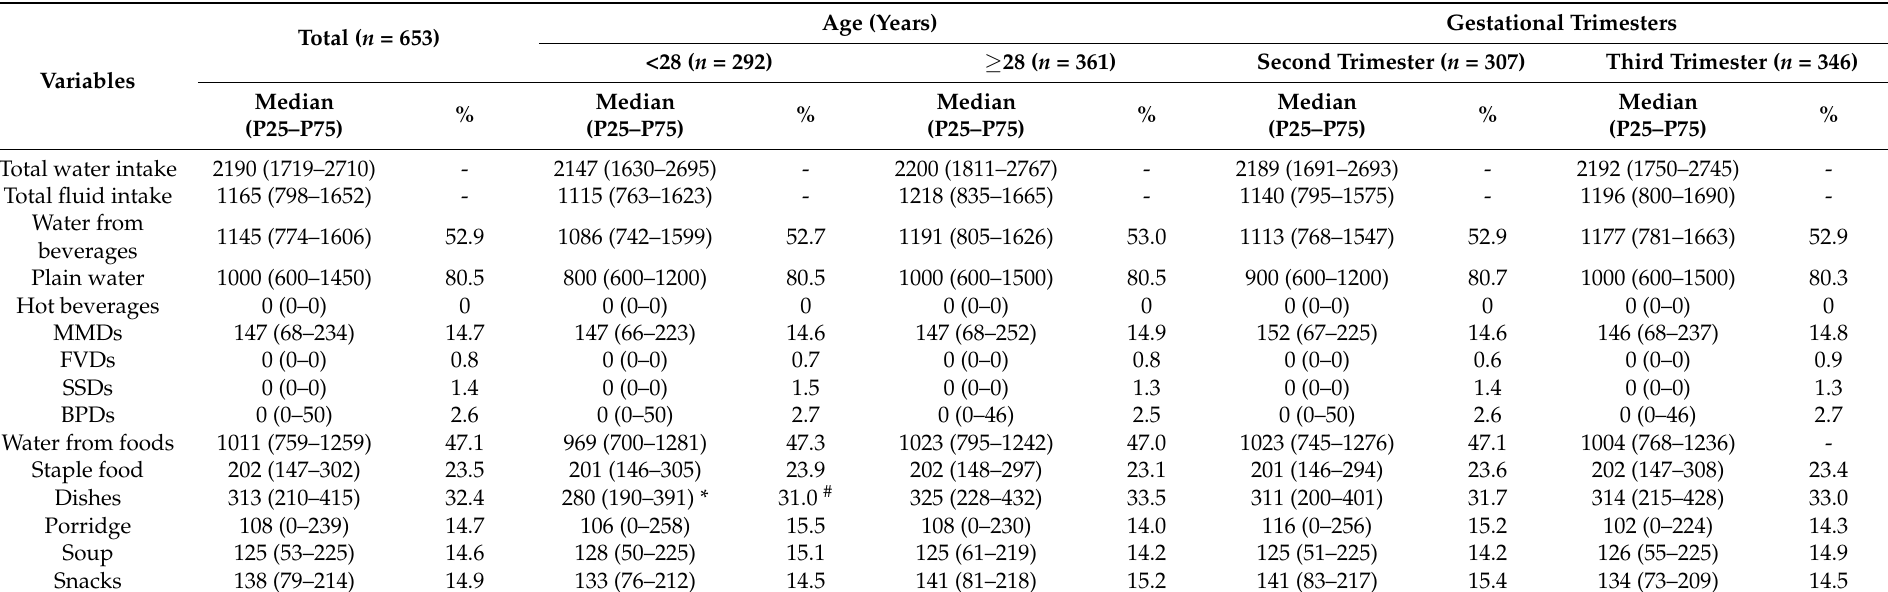
Table 1. Median daily water intake (mL/day) and contribution of water intake from different sources (%) among Chinese pregnant women in 2018 categorized by age and gesta- tional